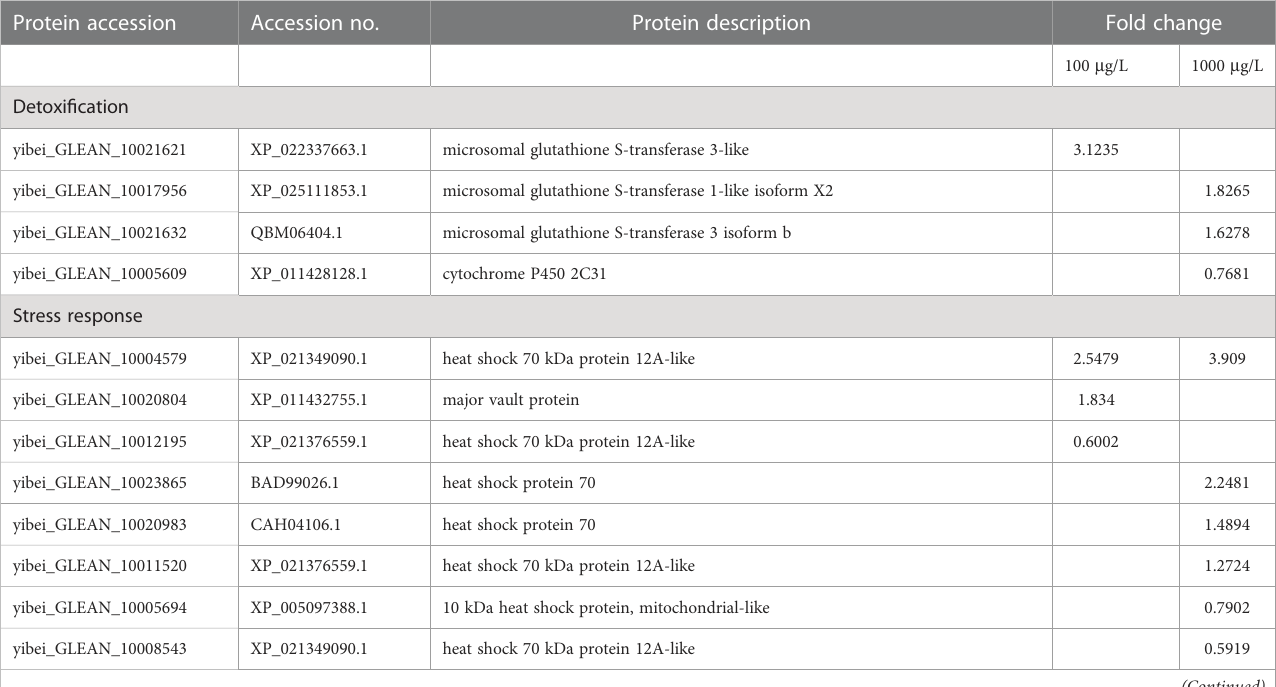
TABLE 1 The key differentially expressed proteins (DEPs) responsive to cadmium in deep-sea mussel gills. Protein accession Accession no. Protein description Fold change